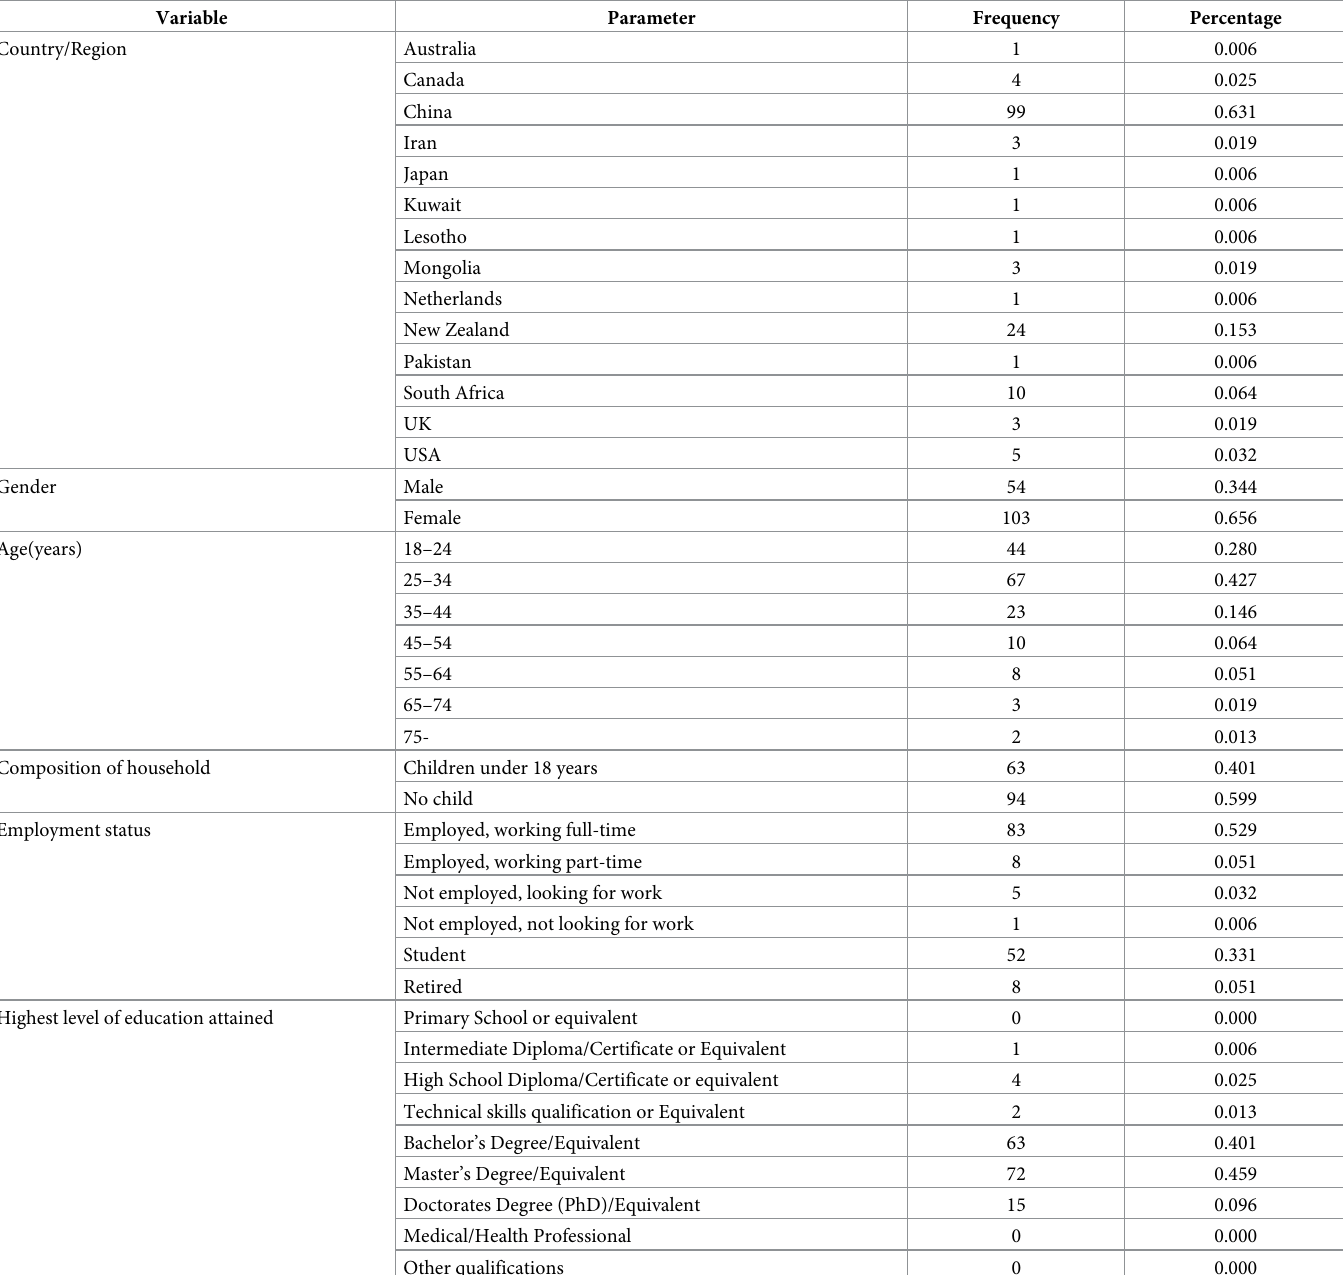
Table 1. Demographic characteristics of respondents (n =